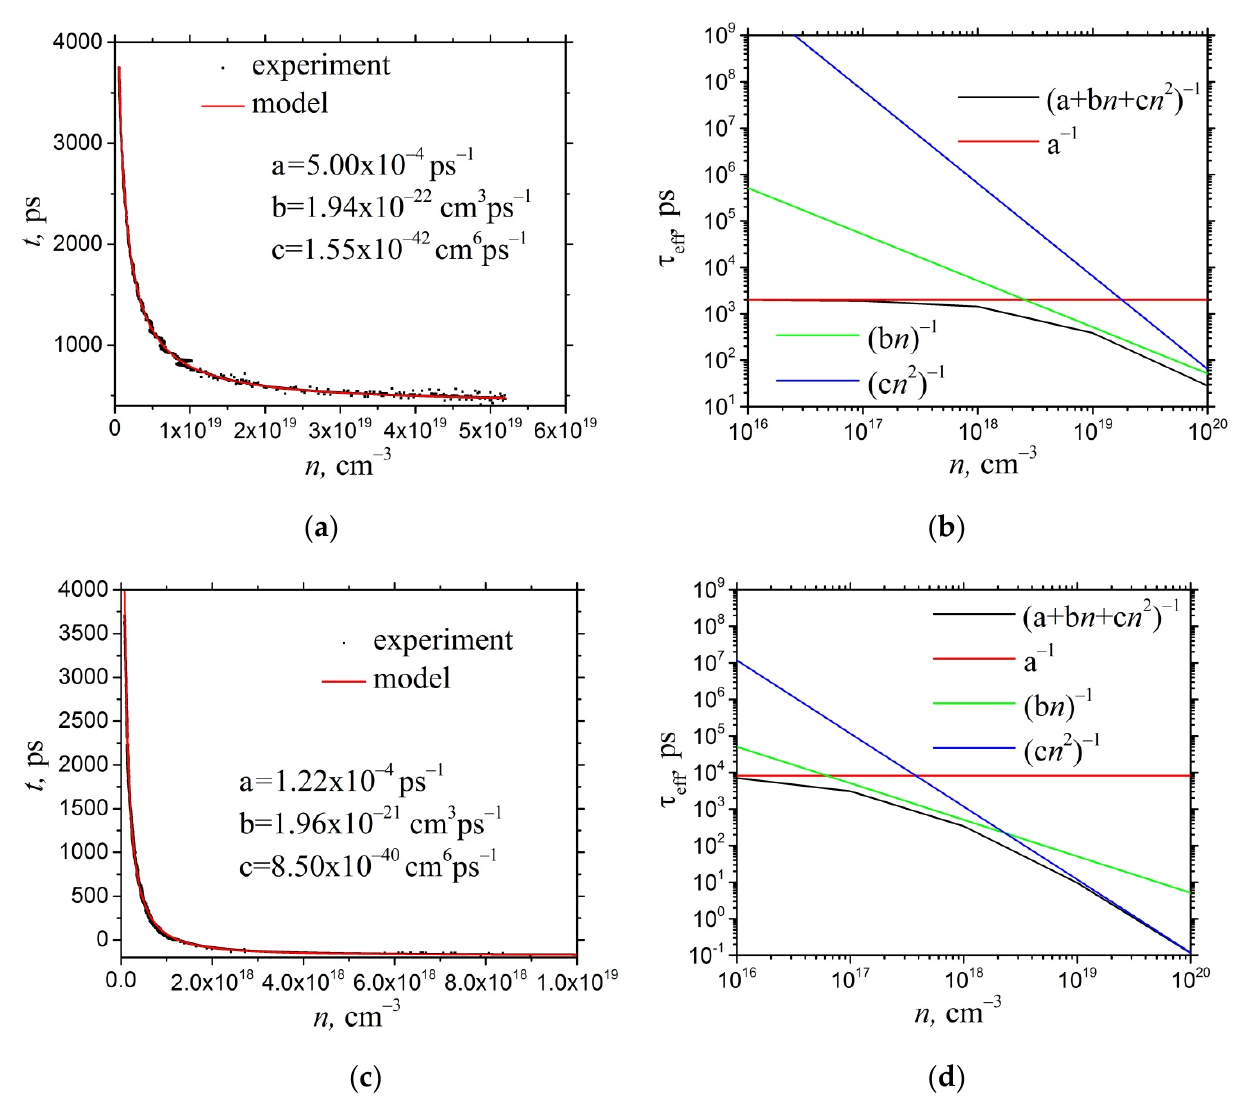
Figure 2. The experimental and fitting (the parameters are given) time dependences of the nonequilibrium charge carrier concentration at the average photoexcitation beam power of 260 mW ( a ) in initial HR GaAs:Cr and ( c ) after grinding the surface; ( b , d ) related calculated injection level dependences of efficient charge carrier lifetime with the resolution into contributions from different recombination